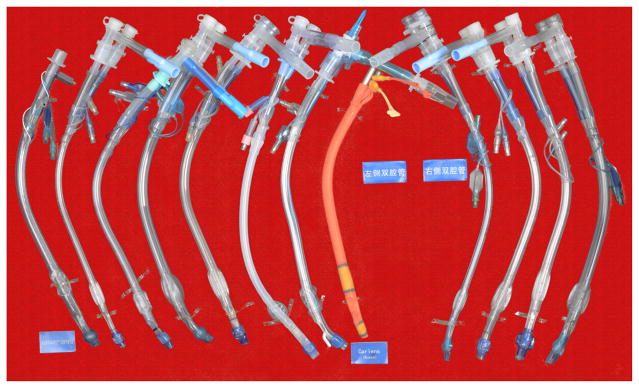
Double-lumen tube.